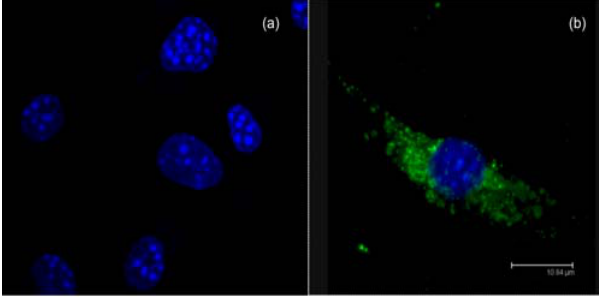
Figure 2. Fluorescence images obtained by confocal microscopy of murine bone marrow-derived macrophages (a) incubated without nanoparticles and (b) with FITC-containing nanoparticles (green). Nucleus stained with DAPI (blue), adapted from